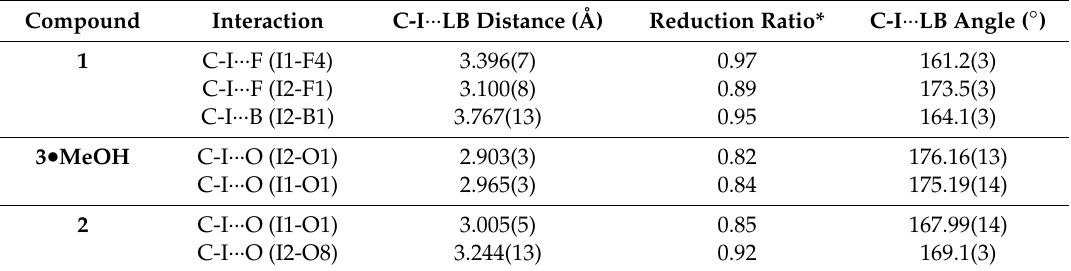
Table 2. Halogen bond parameters for reported structures.